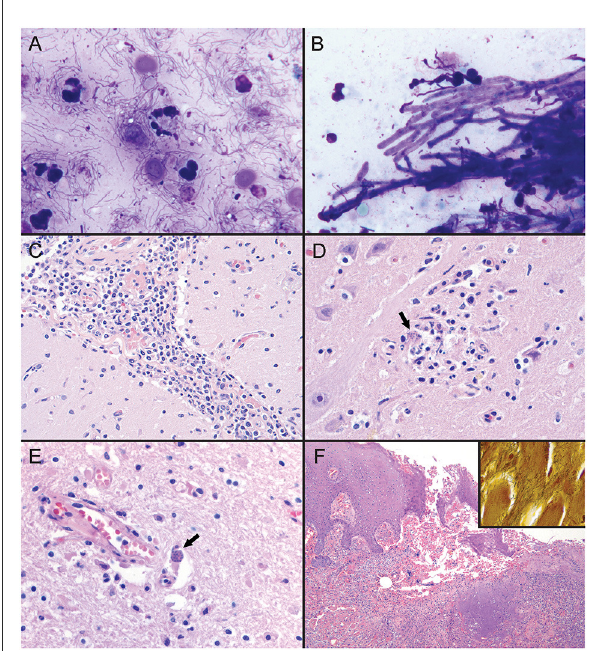
FIGURE3 Tissue sections and imprint cytology from an adult male Stenella frontalis . (A) Imprint of tongue lesion. Mixed bacterial infection with suppurative inflammation, characterized by extracellular and phagocytosed mixed bacilli, diplococci, and spirilliform bacteria (1000x; hematoxylin and eosin stain [HE]). (B) Imprint of tracheal mucosa. There is a dense mat of septate branching fungal hyphae and mixed bacilli (1000x; HE). PCR on frozen lung tissue identified the fungus as Aspergillus fumigatus. (C) Photomicrograph of leptomeninges in cerebral sulcus. Mixed leukocytes, with a predominant population of lymphocytes and histiocytes expand the leptomeninges (400x; HE). (D) Photomicrograph of the right midbrain. Apicomplexan protozoa (black arrow) are present in a focus of malacia and gliosis (600x; HE). (E) Photomicrograph of right frontal cortex. Apicomplexan bradyzoites (black arrow) are adjacent to a vessel in the gray matter. Increased numbers of glial cells are scattered throughout the neuroparenchyma (600x; hematoxylin and eosin stain). PCR on frozen central nervous system tissue identified Sarcocystis speeri within the samples. (F) Photomicrograph of tongue lesion. There is regional ulceration of the glossal mucosa with a underlying bed of cellular and necrotic debris, and intact